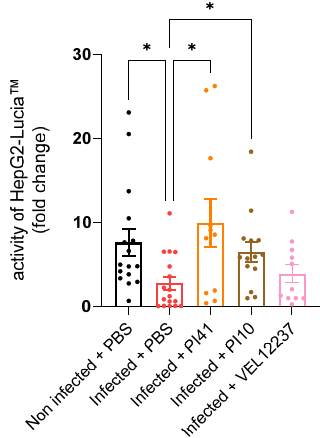
Figure 11. Production of AhR agonists in the feces. Lyophilized feces diluted in cell medium